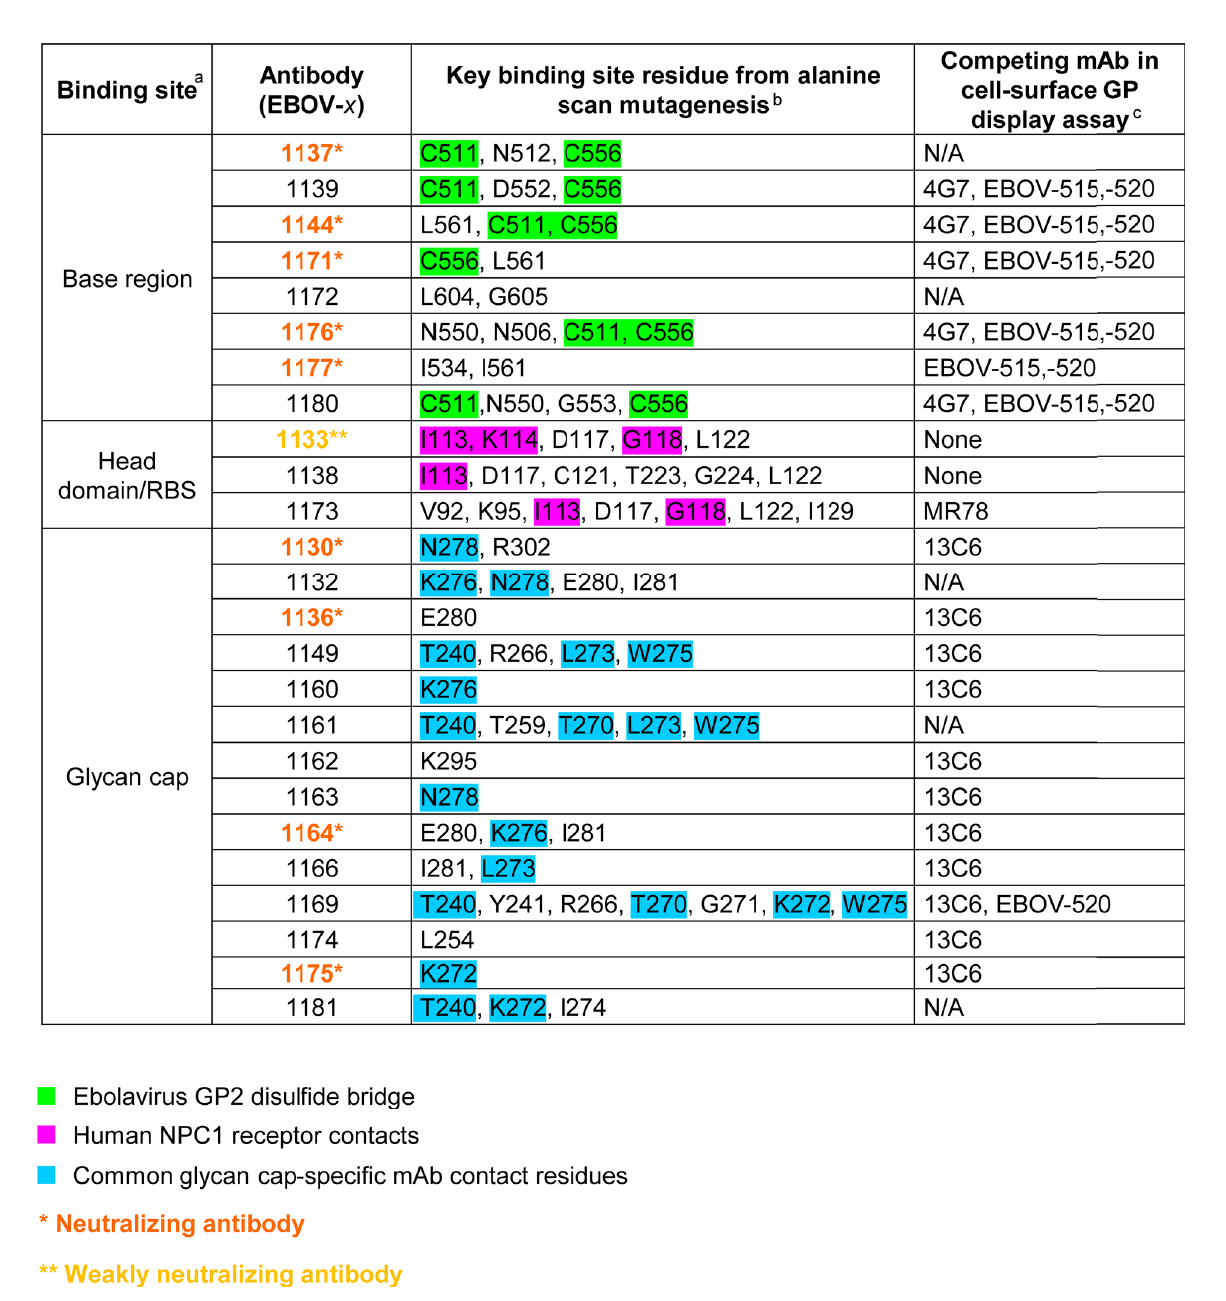
FIGURE 4 | Epitope mapping identi fi ed common features of plasma antibodies recognizing three major antigenic sites on EBOV GP. a Major antigenic sites that were recognized by plasma-represented mAbs include base region, head domain/receptor binding site (RBS), and glycan cap. b GP mutations that reduce binding for indicated antibodies to the GP identi fi ed by alanine-scanning mutagenesis of cell surface-displayed EBOV GP library. Amino acids and their positions for key binding site residues are indicated. Residues that form a disul fi de bridge in the GP subunit near the internal fusion loop (IFL)-heptad repeat 1 (HR1) interface (green), the Niemann-Pick C1 (NPC1) receptor binding site residues (magenta), and residues of the glycan cap that are commonly recognized by glycan cap-speci fi c mAbs are (blue) are highlighted in respective colors. c Competition-binding was assessed by measuring binding of fl uorescently-labeled antibodies to Jurkat-EBOV GP cells that were pre-incubated with indicated unlabeled competing antibody. Competition was de fi ned as <30% of labeled antibody binding in the presence of respective competing mAb relative to a non-competing mAb control. N/A indicates Not Available, for cases in which the antibody exhibited poor solubility after production or after fl uorescent labeling and has not been tested in competition-binding studies. "None" indicates antibody did not compete with any of tested reference